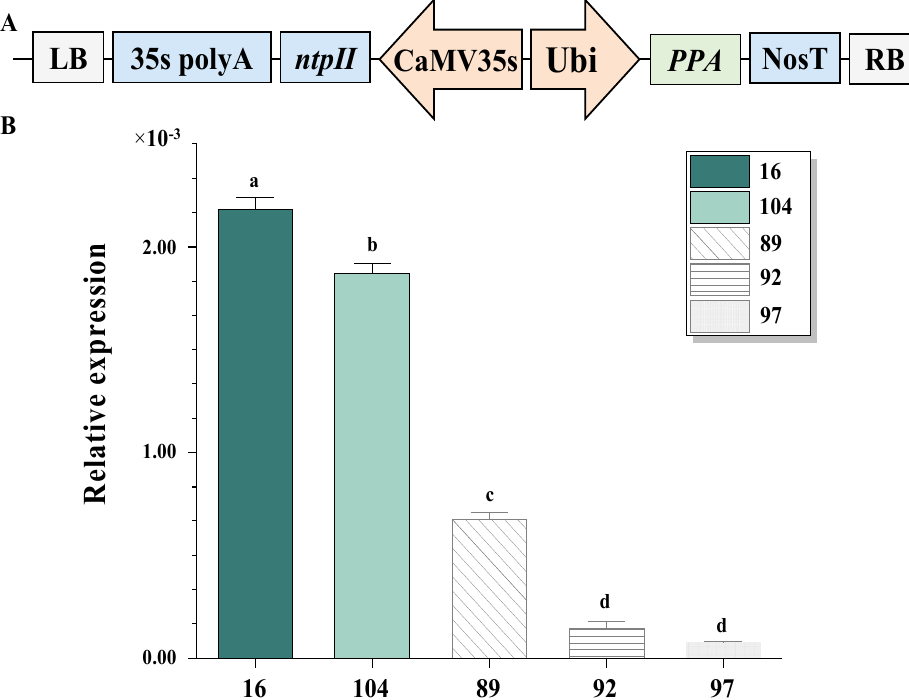
Figure 1. Transformation vector and expression analysis of PPA gene in sugarcane. ( A ) Schematic structure of the recombinant pCAMBIA2301— PPA vector. ( B ) Relative expression of PPA gene in transgenic sugarcane lines and negative control lines. Samples 16 and 104 were PPA transgenic sugarcane lines and the other control plants were negative lines from the same group of transformations. Each value was the mean (±SE) of three replicates, and the letters (a–d) in the figures indicated a significant difference between transgenic sugarcane lines and the control lines (one—way ANOVA, p < 0.05).